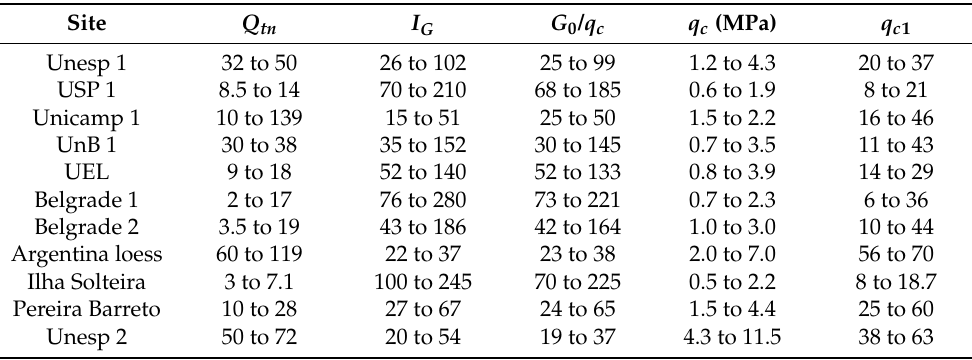
Table 3. Q tn , I G , G 0 / q c , q c , and q c 1 ranges for the soils from all